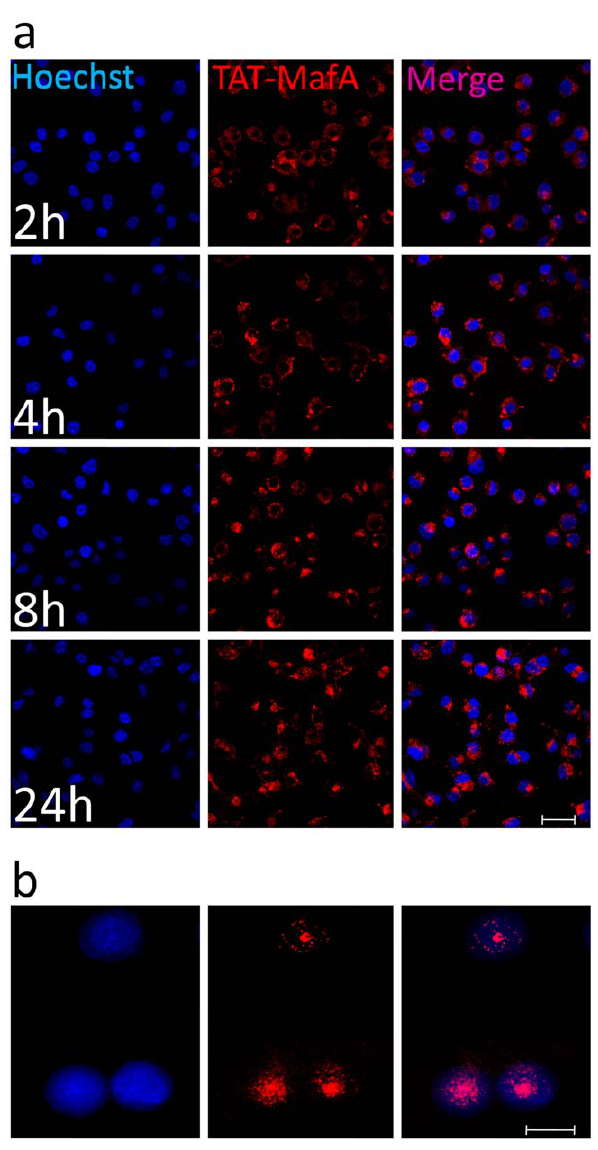
Figure 1. TAT-MafA uptake in b -TC3 cells. (A)TAT-MafA protein (1 m g/ m l) was labeled with Alexa Fluor 568 and added to the culture medium of b -TC3 cells grown in glass bottom dishes (P35G-1.5-20-C 35 mm, MatTek Corporation, Ashland, MA) to ensure maximal optical clarity for live confocal microscopy. Hoescht (blue) was used as nuclear counter-staining (first column). An overlay of both channels is seen in the last column. The culture medium was removed and cells washed in PBS prior to each observation in order to eliminate free extracellular immunofluorescence background. Disturbance of the cultures prior to the time of observation was prevented by plating each individual group (time point) independently. Size bar: 20 m m. (B) Detail of nuclear localization of the protein after 8 h by live confocal microscopy (staining as above). Size bar: 5 m m.